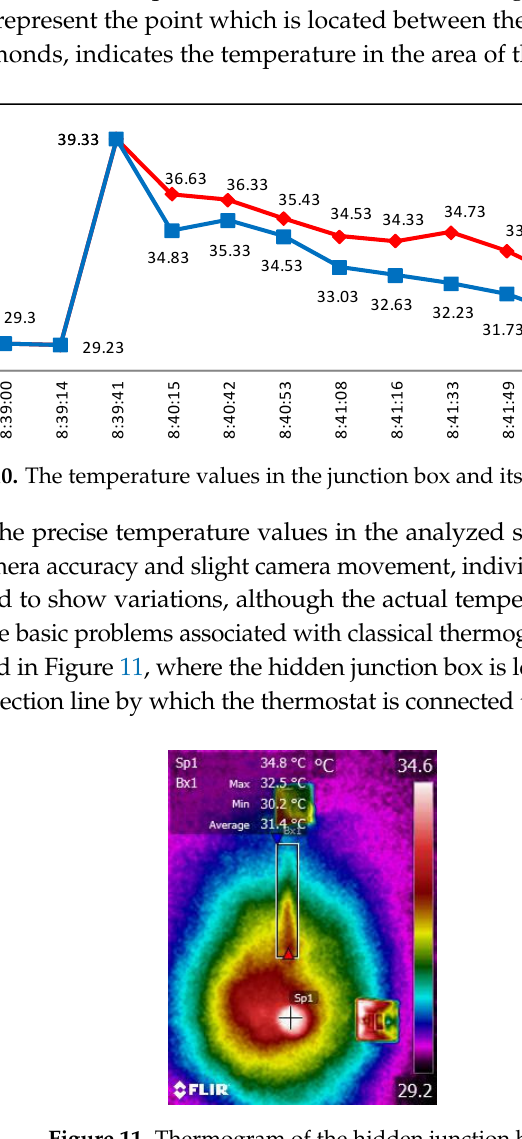
( b ) Figure 12. Finding a power supply cable with active thermography. The position of the power supply cable can be often observed by applying thermal excitation. When installing a lighting fixture, the danger accidental mechanical damage of a power supply cable is, in that case, reduced to a minimum. Encouraged by the previously described experiments with thermal step excitation, the idea for research regarding finding hidden elements in historical buildings was initiated. 3.5. Parameters affecting radiometric accuracy of IR thermography There are a number of parameters that ultimately define the accuracy and repeatability of a radiometric measurement. These include an object, surface, thermal environment, atmosphere, and instrument. Consideration should also be given to the measurement method or instrument that is establishing the deviation, as it may be the source of an error rather than the infrared instrument. Surface temperature considerations depend upon a type of a thermal generator. There are three fundamental types of internal thermal generators, namely (i) a constant temperature generator example electrical fault, (ii) a constant power generator example building, and (iii) a finite energy source, for example, a motor that has been switched off. Heat transfer from these fundamental types of thermal generators can be complicated over a period by thermal capacitance(s) of the material between the energy source and the surface. An overview of the material characteristics and the typical emissivity necessary for the implementation of a thermographic analysis is given in Table 2 [14]. Table 2. Thermo-physical-optical properties of various materials [14].